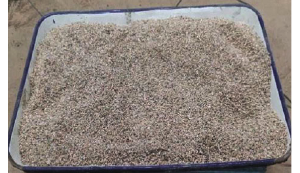
Figure 1: 1.18mm ~ 2.36mm coarse sand.